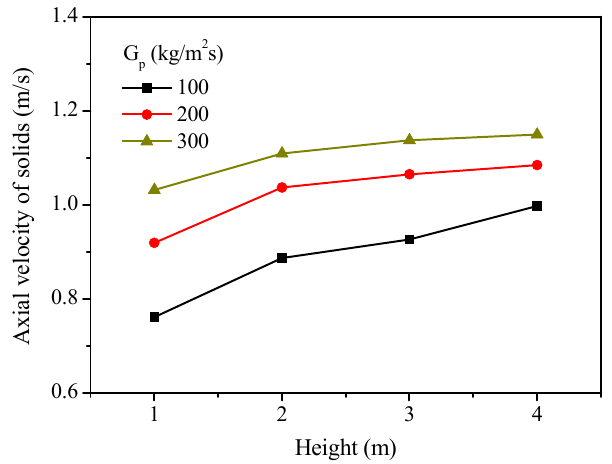
Figure 7. Distribution of mean axial solids velocities as a function of height with different solids fluxes.